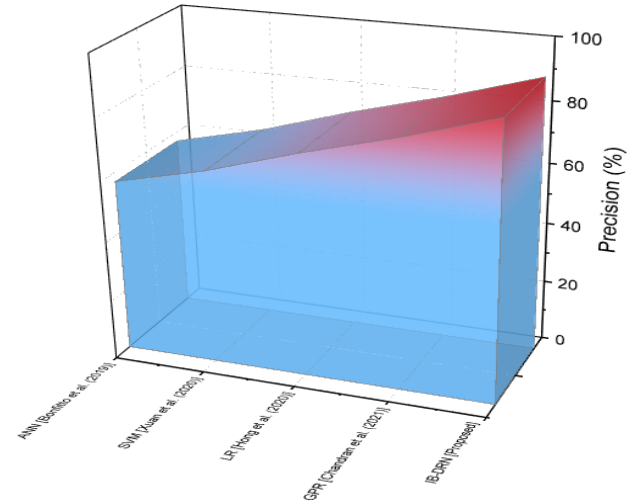
Figure 4. Precision outcomes of existing and proposed methodologies [ANN [Bonfitto et al. (2019)], SVM[Xuan et al. (2020)], LR[Hong et al. (2020)], GPR [Chandran et al. (2021)]].